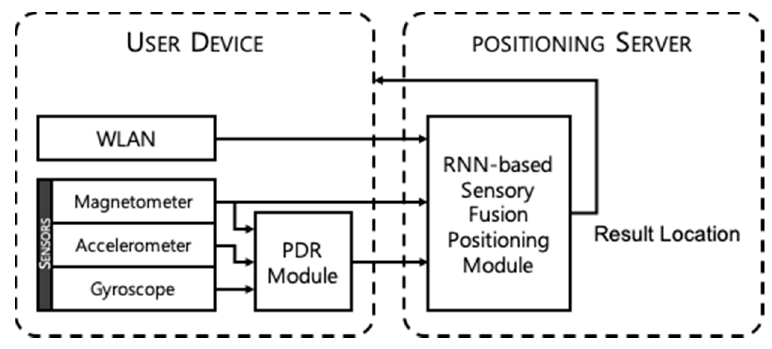
Figure 2. Structure of the proposed method.